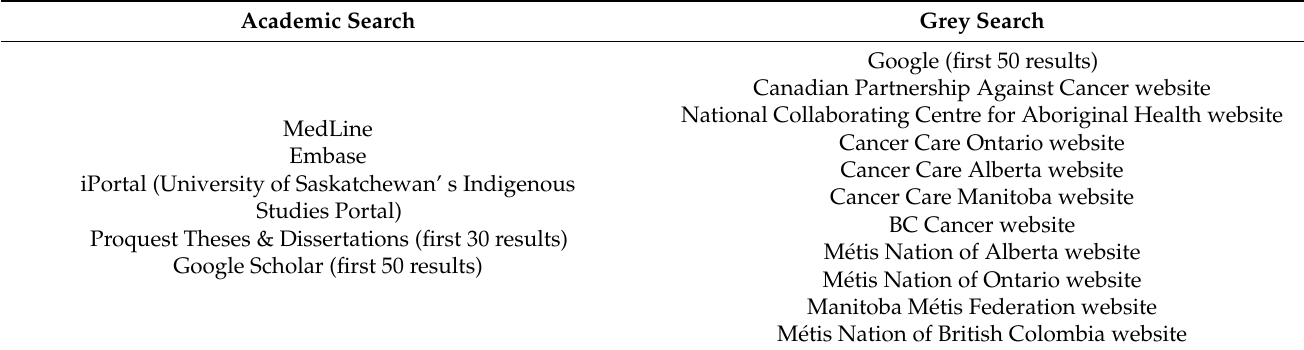
Table 1. Academic and grey literature sources searched.